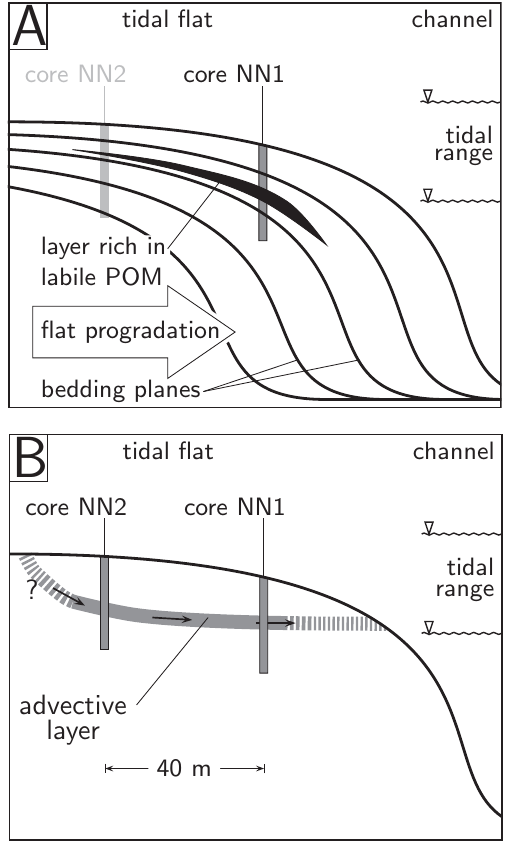
Fig. 4. Alternative scenarios to explain fast OM degradation in deep sediment. (A) Scenario A: eccessive sediment supply causes the tidal flat to vertically grow and laterally prograde into the chan- nel by that burying the labile POM deposit. Scenario calculations are limited to core NN1.“Bedding planes” indicate former surface planes. (B) Scenario B: an advective zone or subterranean aquifer in 1–2mbsf connects core NN2 and core NN1 to a hypothetical SPOM source upstream of core